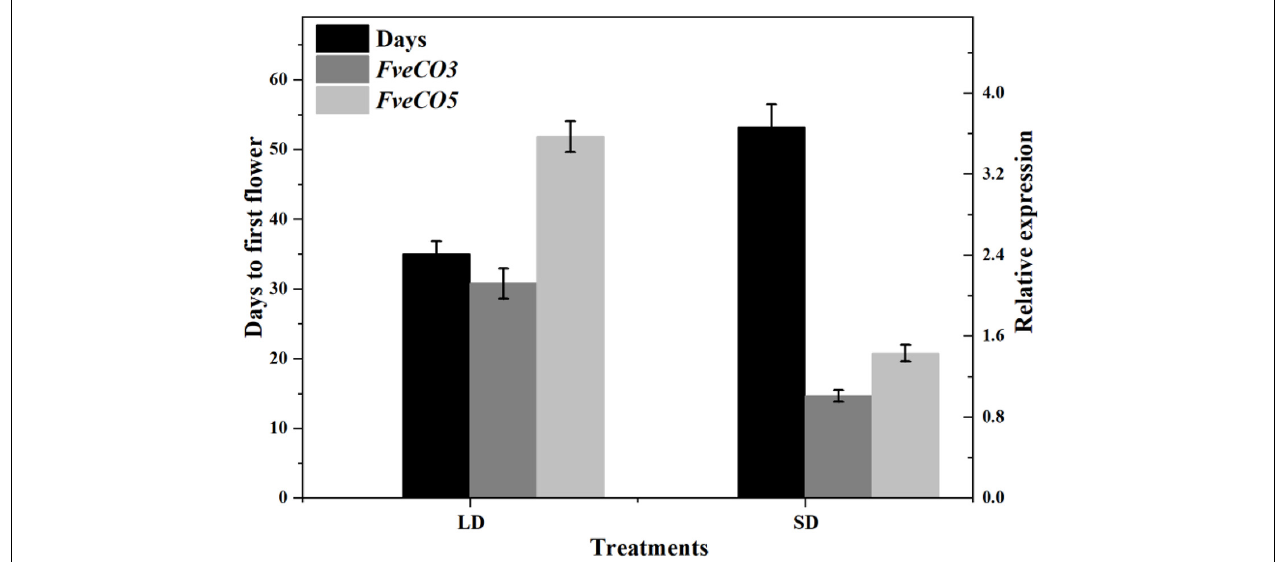
FIGURE 9 | Negative correlation of FveCO3 and FveCO5 expression with flowering time in woodland strawberry “Ruegen.” The black bars indicate the days needed to flower (flowering time); the gray bar and light gray bar indicate the expression of FveCO3 and FveCO5 , respectively. Ten plantlets were used for each. Three independent samples were used in the expression analysis. Values are the mean ± SD.